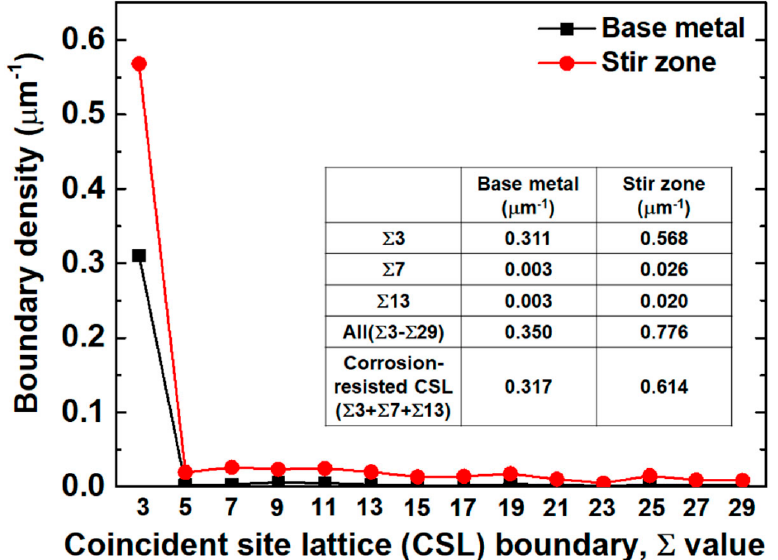
Figure 7. Coincident site lattice boundaries distributions of base metal and stir zone specimens together with their fractions.